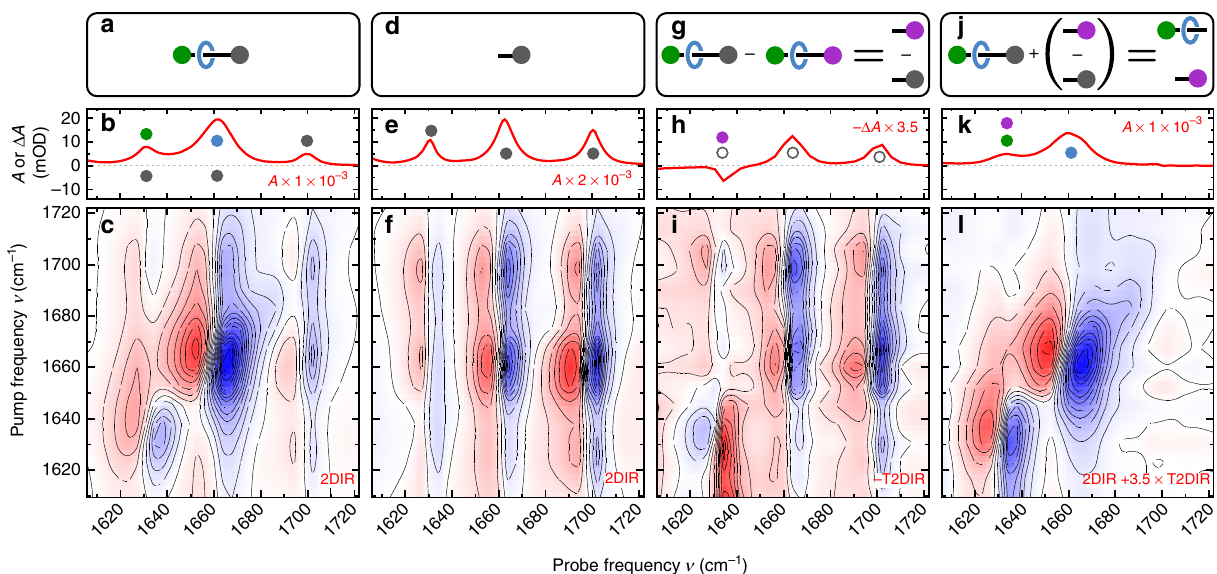
Fig. 3 Unravelling a congested 2DIR spectrum with T2DIR. a , d , g , j are schematic representations of the components of the molecular shuttle belonging to the spectra. In the 1DIR ( b ) and 2DIR ( c ) spectra of the molecular shuttle, the peaks due to vibrations of the ni station have signi fi cant overlap with the peaks due to the vibrations of the succ station and the macrocycle. The 1DIR ( e ) and 2DIR ( f ) spectra of the isolated ni station, which only contain absorption peaks due to vibrations of the ni station. At 50 ns after UV excitation, the absorption change observed in the T1DIR ( h ) and T2DIR ( i ) spectra are due only to changes in the vibrational frequencies in the ni station. The T2DIR spectrum in ( i ) has been multiplied by − 1 for better comparison with the 2DIR spectrum of the chemically isolated ni stopper in ( f ). The constructed ni-free 1DIR ( k ) and 2DIR ( l ) spectra of the molecular shuttle show the absorption peaks due to the succ station and macrocycle. The coloured closed and open circles correspond to the labelled components of the molecular shuttle in Fig. 1b. The 2D spectra are recorded with perpendicular ( ⊥ ) polarisations of the IR-pump and IR-probe